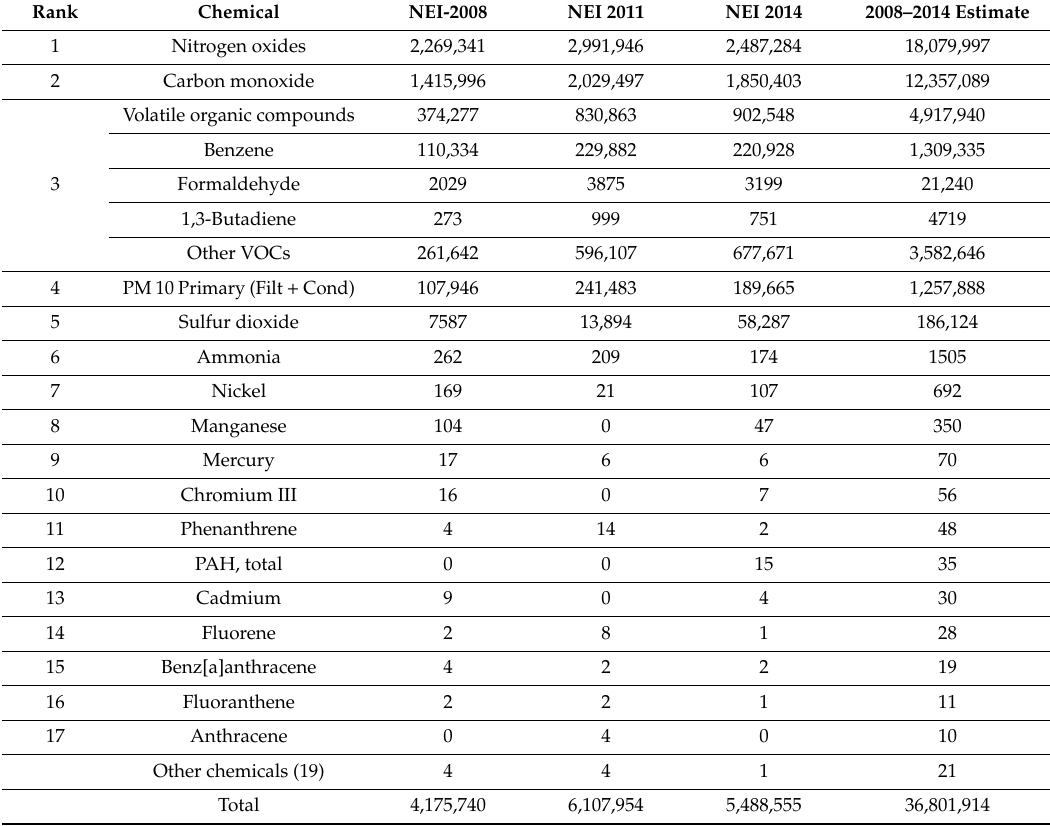
Table 2. The United States Environmental Protection Agency (USEPA) National Emissions Inventory (NEI) emissions (pounds) by chemical: 2008–2014.